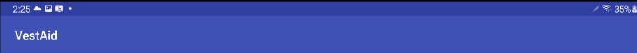
6 of 19 Figure 2. VestAid start page.